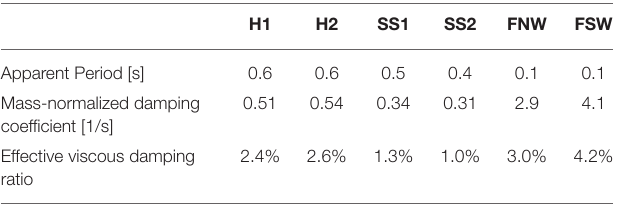
TABLE 3 | Summary of results for small-scale test specimen responses under design-level ground